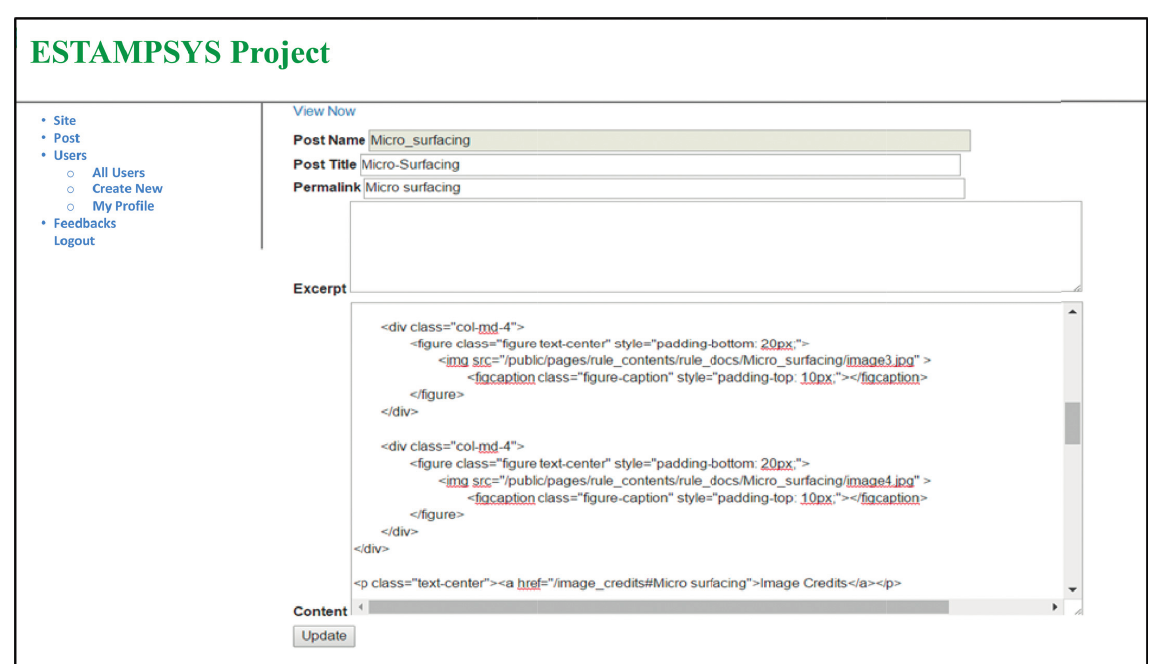
Figure 13: Screenshot of the update system